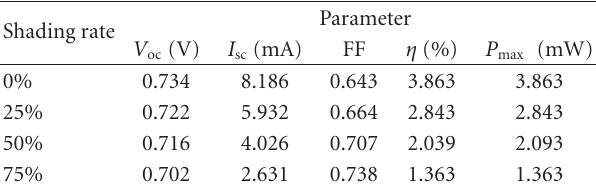
Table 1: The characteristics of the unit cell according to the shadowing e ff ect.